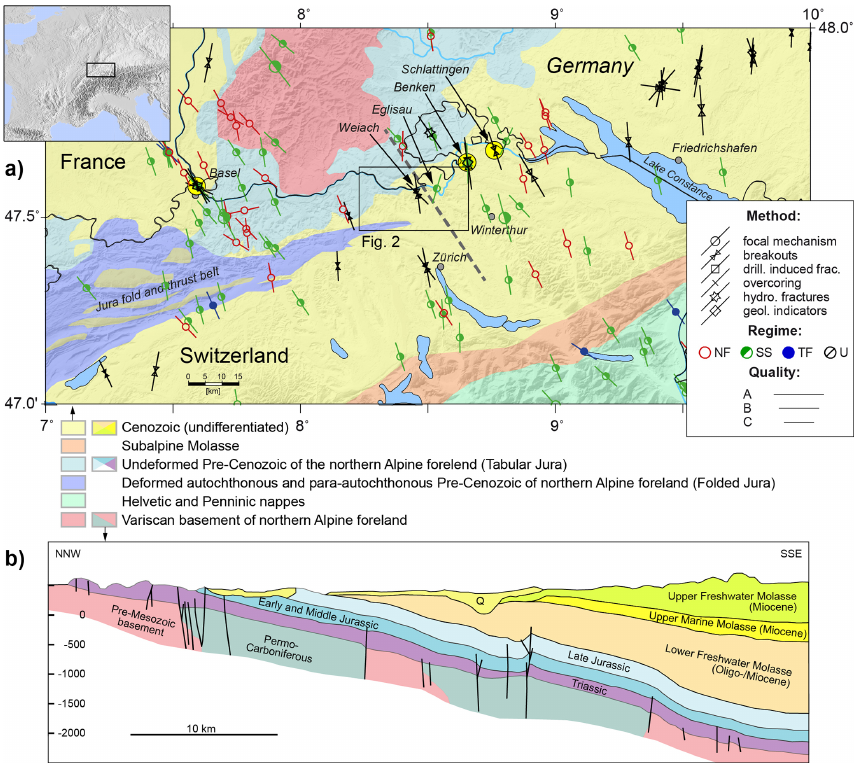
Figure 1. General geological setting of the model area in northern Switzerland. (a) Main geological units (after Nagra, 2008) and 128A–C quality data records of the revised World Stress Map database release 2008 (Heidbach and Reinecker, 2013; Heidbach et al., 2008). Bars indicate orientation of maximum horizontal stress S H , symbols indicate type of stress indicator and colours relate to tectonic regime with red for normal faulting (NF), green for strike-slip faulting (SS), blue for thrust faulting (TF), and black for unknown tectonic regime (U). Yellow circles show the three locations where stress magnitude data are available (Basel, Benken, Schlattingen). Black dashed line denotes the location of the cross section in (b) . (b) Generalized geological cross section through the main lithological layers in the northern Alpine foreland, modified after Mazurek et al.